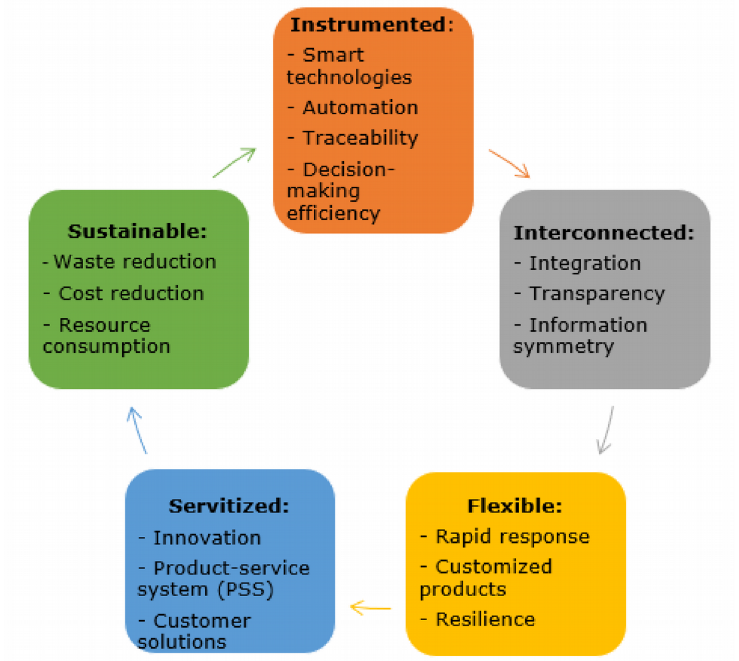
Figure 3. Conceptual cyclic framework of a smart supply